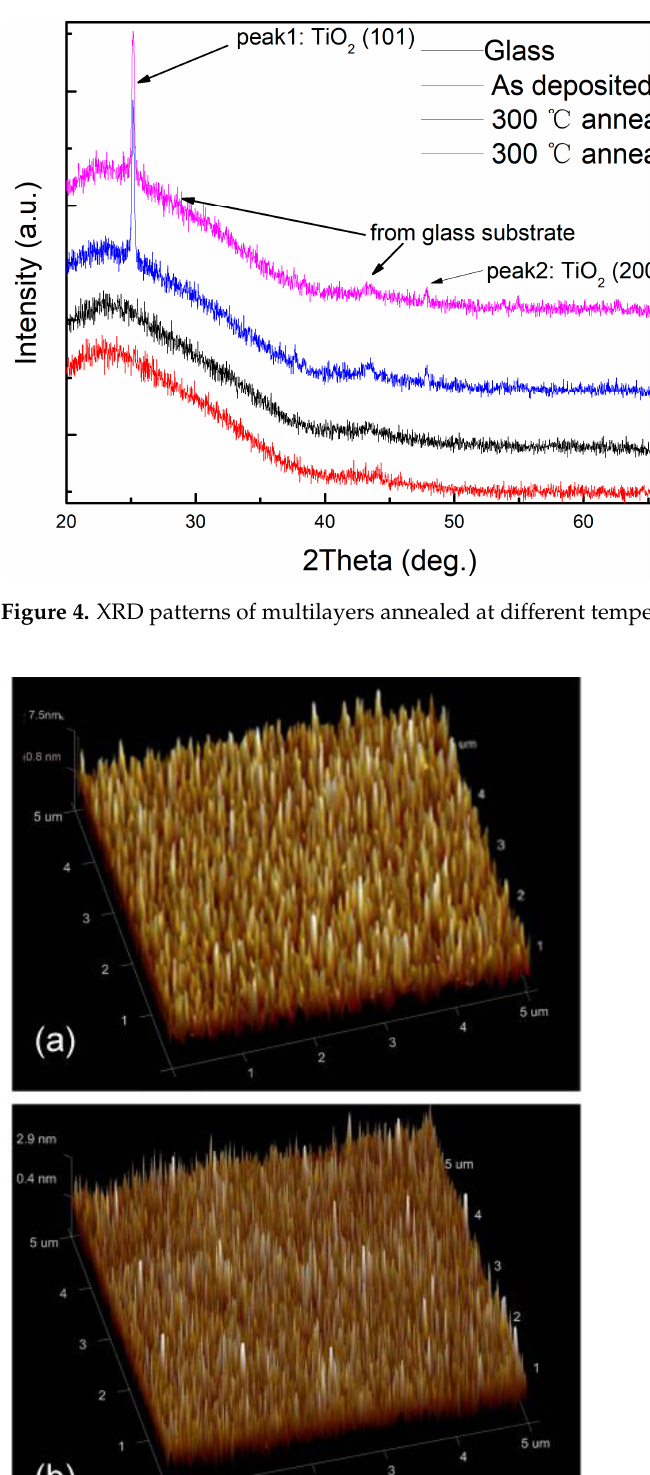
Figure 5. Atomic force microscopy (AFM) image of ( a ) as-deposited multilayer and that ( b ) an- nealed at 400 °C.